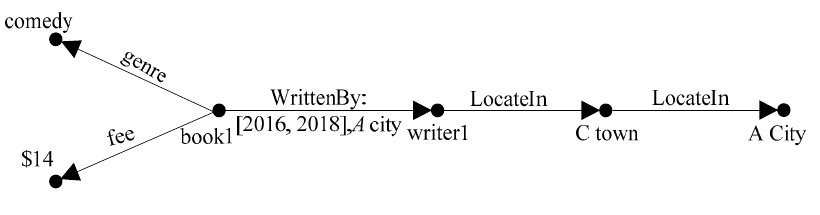
Figure 6. The result of performing the filter operation over P and G .